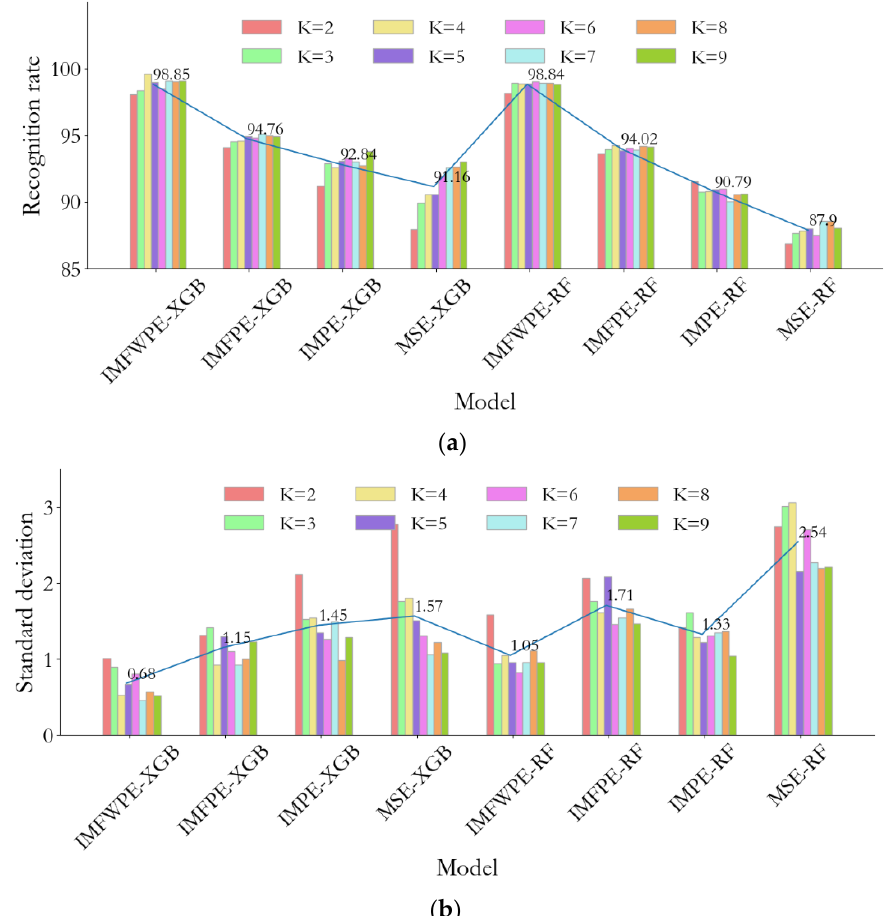
Figure 11. Diagnostic rates of different models at different fold numbers: ( a ) diagnostic rates (mean)